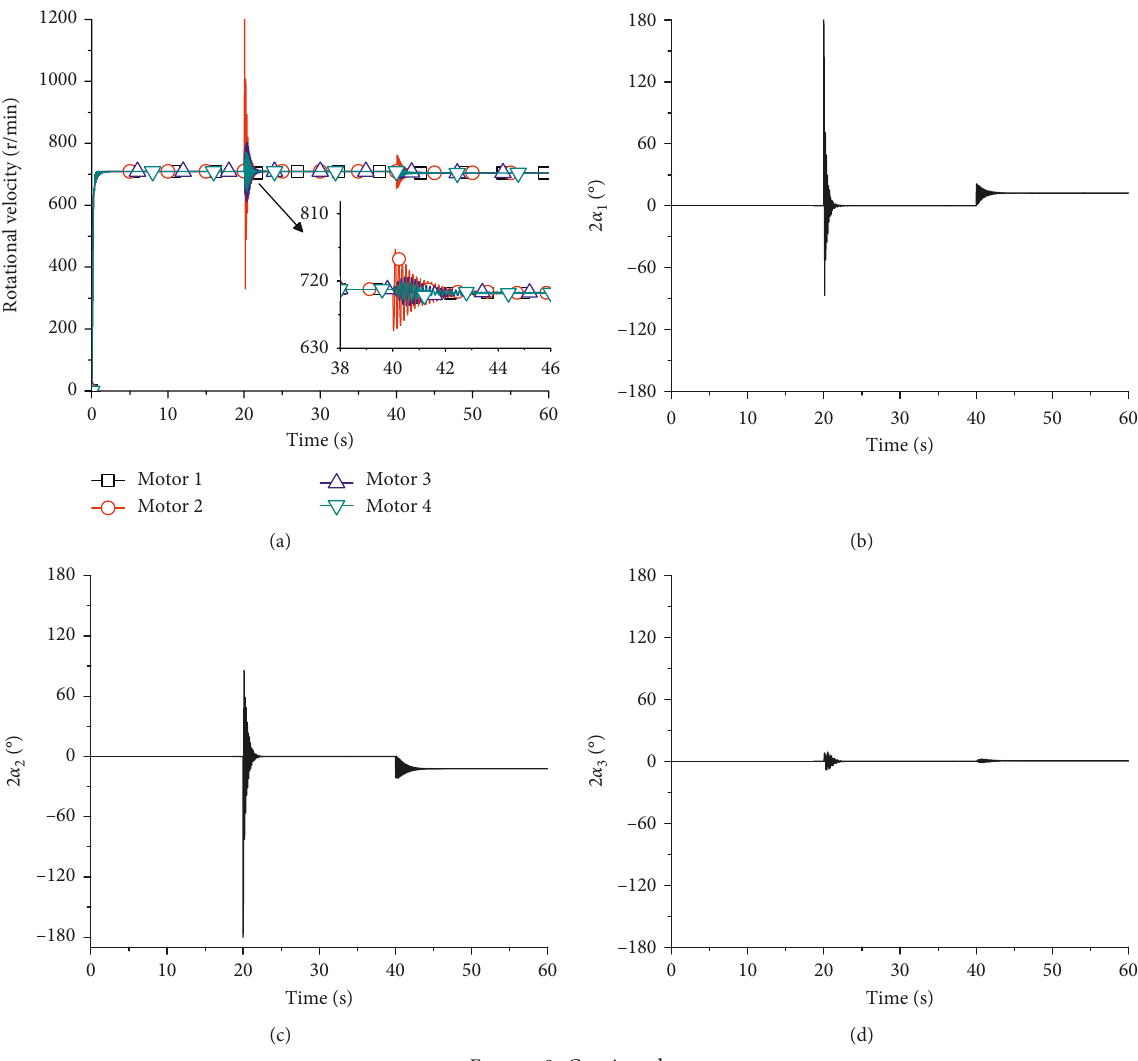
Figure 7: Results of computer simulations for η difference between vibrators 1 and 2; (c) phase difference between vibrators 2 and 3; (d) phase difference between vibrators 3 and